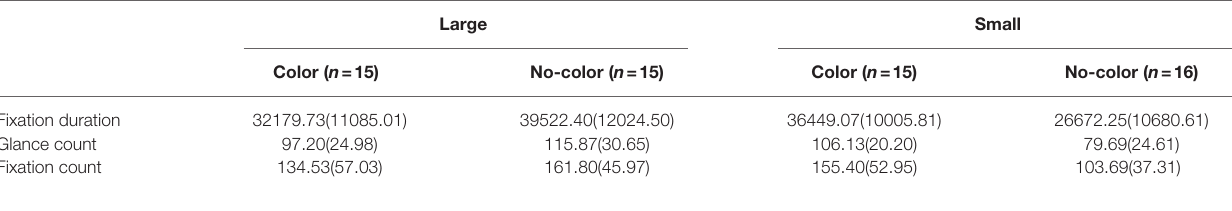
TABLE 2 | Eye movement for different label sizes with and without color levels.